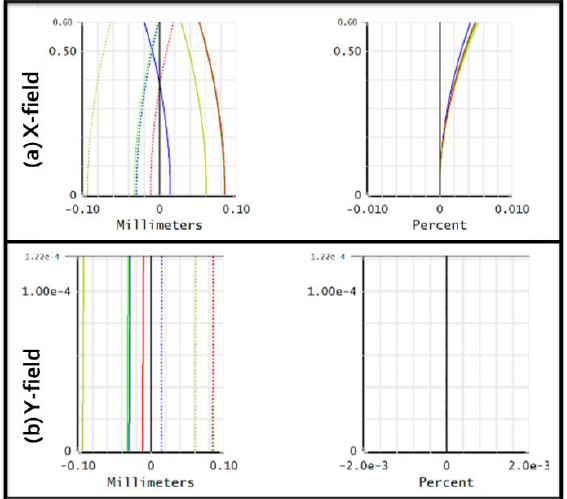
Figure 12. Field curvature and distortion results of the overall